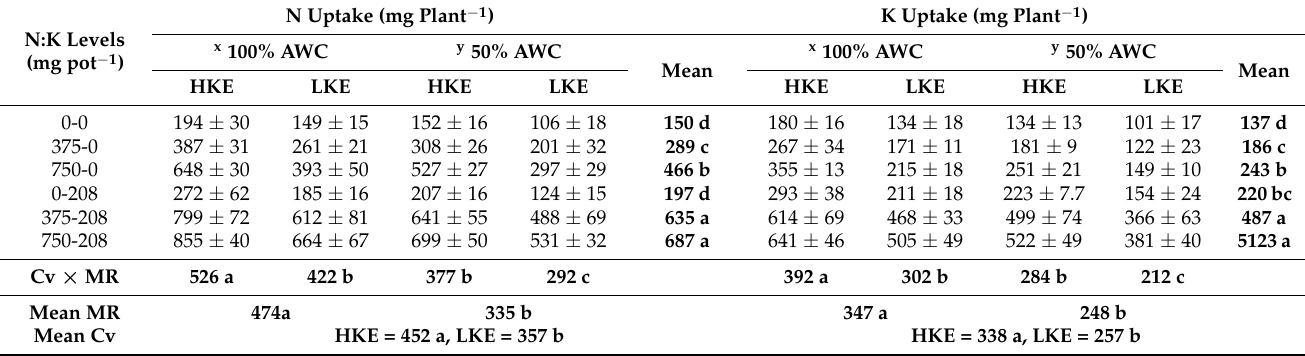
Table 2. Effects of N:K levels on N and K uptake in cotton cultivars under varied irrigation levels.